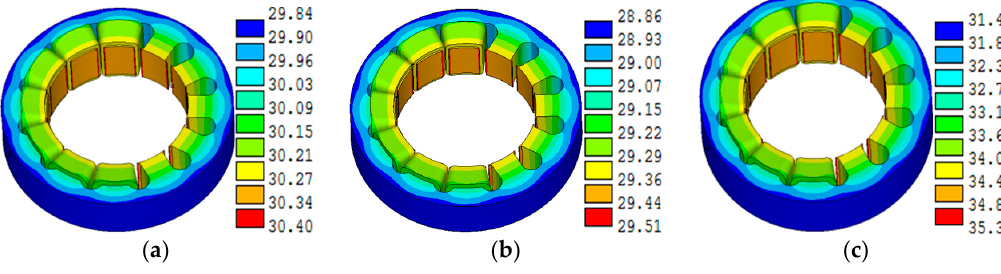
Figure 20. Stator temperature distribution of the machine with HTS wires (°C); ( a ) 0 At AMMF; ( b ) 600 At AMMF; and, ( c ) 900 At AMMF.